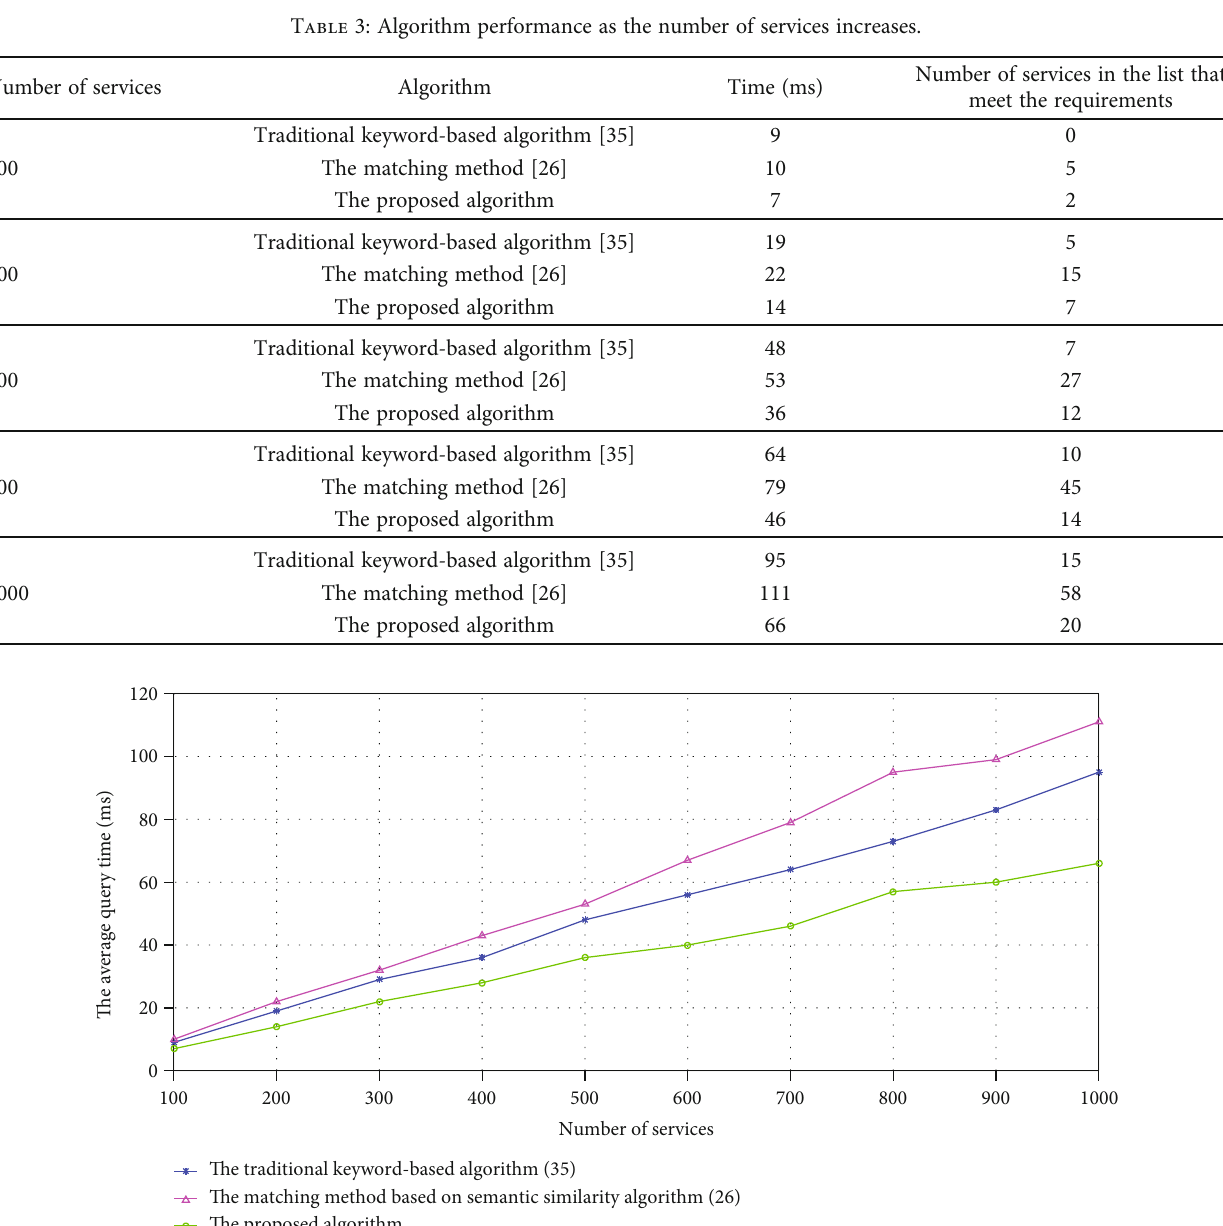
Figure 6: The average query time as the number of services